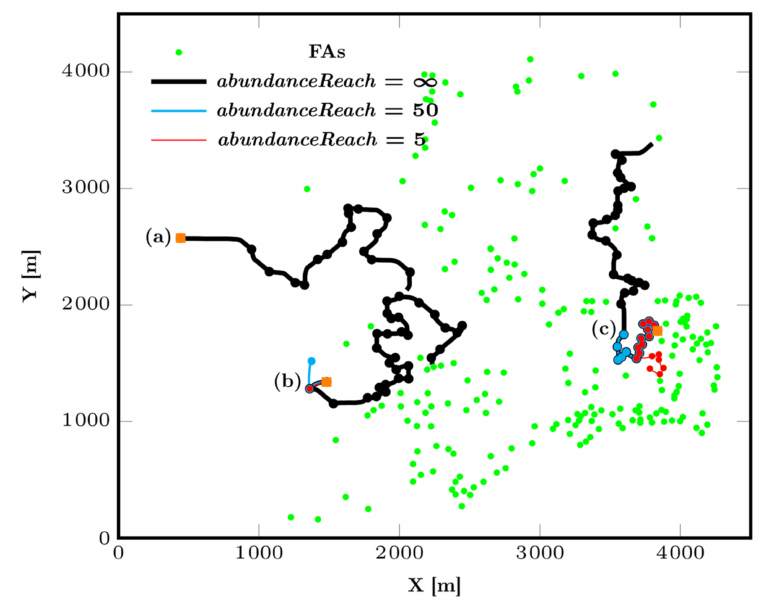
Figure 6. CM trajectories for explorationZone = 1 and abundanceReach values of 5, 50 and ∞ . The orange square indicates where the group of particles was generated. (a,b) The CM remains stuck for abundanceReach = 5 and 50. (c) Due to a higher density of feeding area, each value of abundanceReach allows the CM of the group to progress.